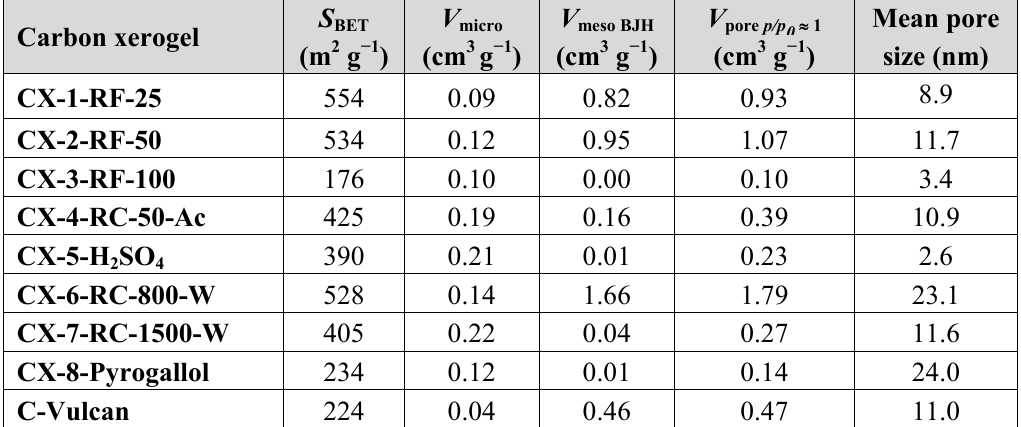
Table 1. Surface area and pore volumes obtained from N carbon xerogels